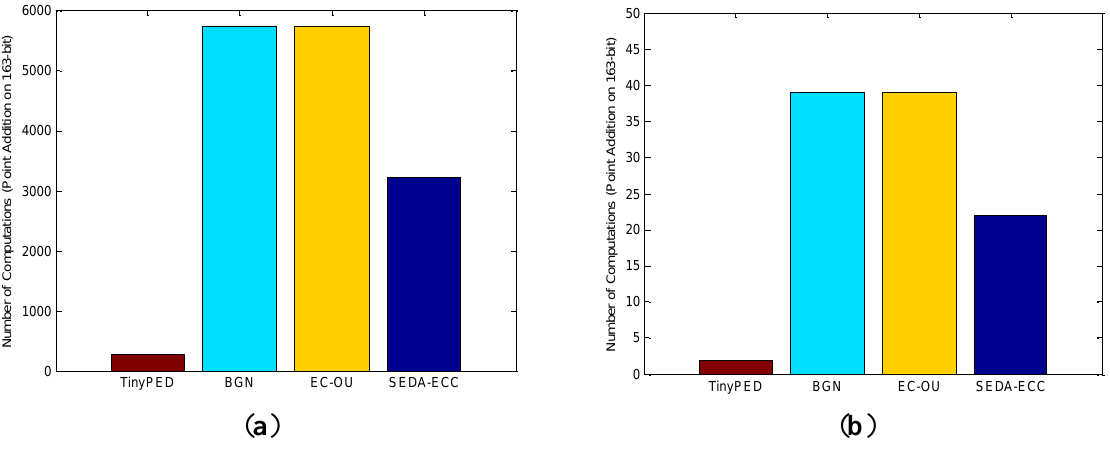
Figure 7. The comparison of cost; ( a ) encryption cost; and ( b ) aggregation cost.